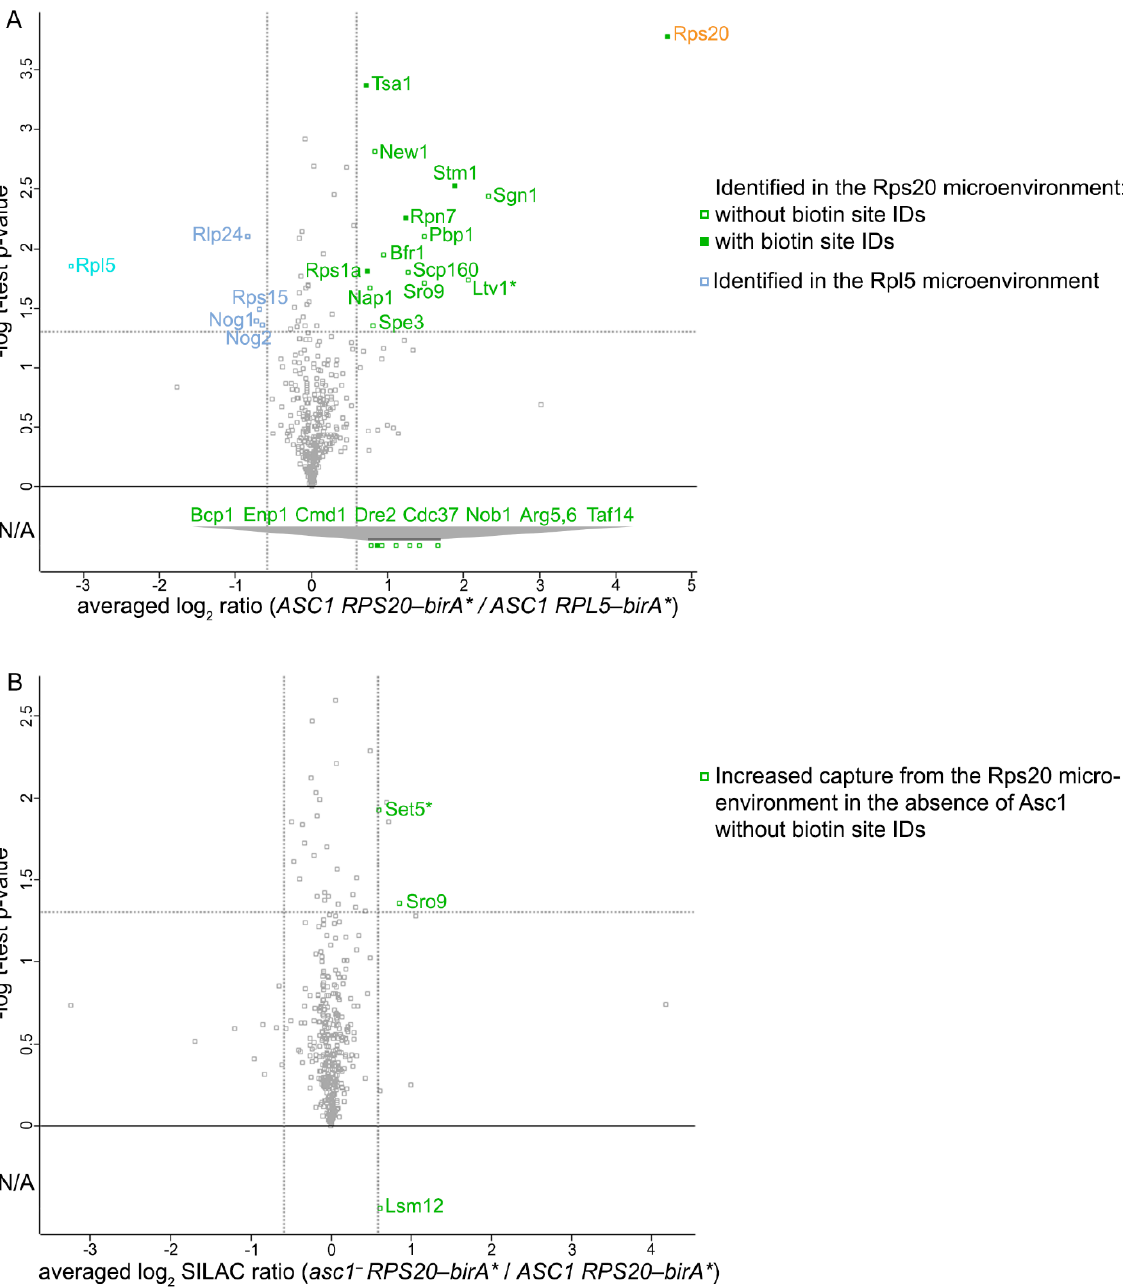
Figure 4. Proteins occurring proximal to Rps20 and their Asc1-dependence. Volcano plots show the averaged log 2 SILAC ratios for ( A ) ASC1 RPS20-birA* ( light SILAC) to ASC1 RPL5-birA* ( medium SILAC) and ( B ) asc1 − RPS20-birA* ( heavy SILAC) to ASC1 RPS20-birA* ( light SILAC) on the x-axes and the -log 10 ( p -value) of the t-test on the y-axes. Gray dotted threshold lines indicate a p -value of 0.05 (horizontal) and a log 2 SILAC ratio of 0.585 or −0.585 (vertical). Proteins with two instead of three quantification values (w/o p -values) that passed the threshold of two values ≥ 0.585 are depicted below the horizontal 0-value line with their averaged log 2 SILAC ratios (L/M in ( A ) and H/L in ( B )). Not applicable (N/A) on the y-axis indicates that no t-test was performed for these proteins and thus no p -value is available. For proteins highlighted with an asterisks (*), no information about their protein abundance was obtained from the proteome data. For all other proteins that are highlighted in red or green, at least one quantification value was obtained from the proteome analysis. Gray squares represent proteins not passing the set criteria for proximity ( A ) or Asc1-dependence ( B ). For details see Tables S1 and S6–S9.